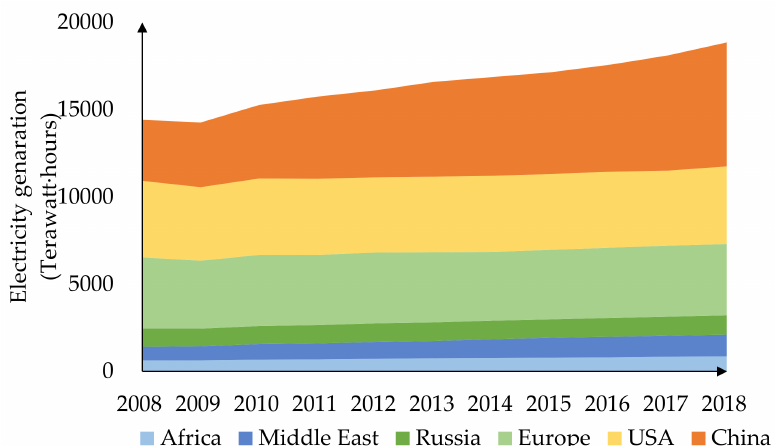
Figure 1. Electricity generations of major countries and